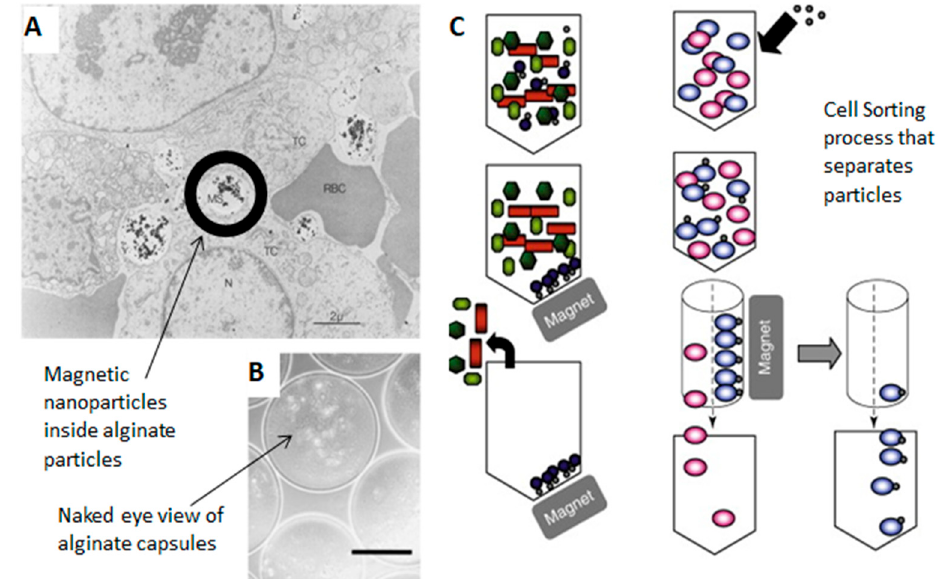
Figure 9. Applications of magnetics with proteins and polysaccharides in nanomedicine. ( A ) TEM image of a tumor with magnetic particles in the interstitial space of the tumor (Scale bar: 2 µ m). ( B ) Particles with ferrofluid in the core of alginate capsules. These are light microscope images (Scale bar: 200 µ m) ( C ) Cell sorting process that separates particles with magnets. (Reproduced with permission from Refs [81,151,168], ( A ) Copyright Elsevier, 2003; ( B ) John Wiley and Sons, 1998; ( C ) Taylor & Francis, 1998).